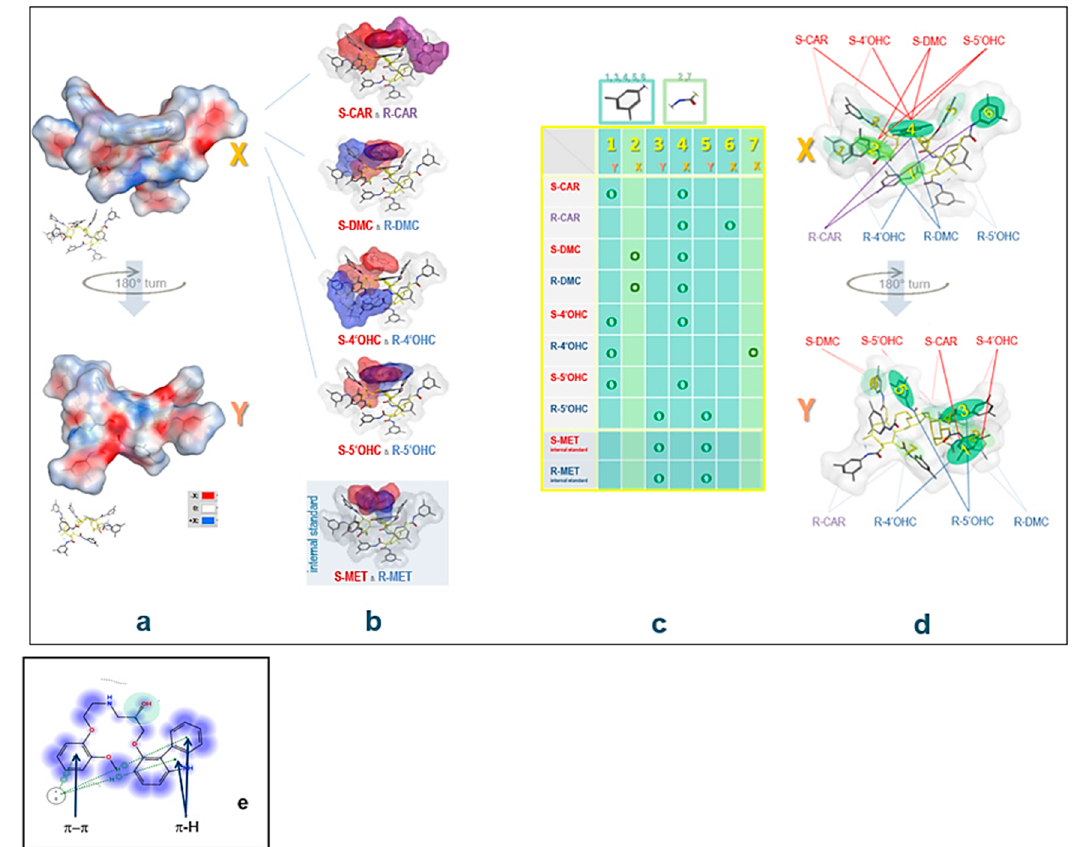
Figure 9. Interactions of CAR, 4 ′ OHC, 5 ′ OHC, and DMC (and MET) enantiomers with the CSP: Highscore docking poses and character of major binding interactions of the analytes at the CSP. Top left side (a,b): ( a ) CSP polar surface (TPSA) of the CSP 3-unit segment, front view = X, back view = Y; ( b ) analyte enantiomers of CAR, DMC, 4 ′ OHC, and 5 ′ OHC attached to grey CSP surface (enantiomer color code: red surface for S -enantiomers (all β -adrenoceptor antagonistic enantiomers, except for the α -/ β -adrenoceptor antagonistic S -CAR), purple surface for the α 1 -adrenoceptor antagonistic R -enantiomer of the parent CAR, blue surface for α 1 -inactive metabolite R -enantiomers). Top right side ( c , d ): ( c ) Binding areas at the CSP: Table listing the two rim regions of high-score binding for each of the analytes, which characterize the expansion of analyte-CSP high-score docking (for all 8 analytes as well as the internal standard). There are seven major regions (1–7), where regions 1, 3, 4, 5, and 6 are representing 3,5-dimethyl phenyl residues and regions 2 and 7 the carbamate spacers. The respective location on the CSP surface is indicated, X = front, Y = back. ( d ) Location of regions 1–7 on the CSP unit: X front view, Y back view, regions 2, 4, 6, and 7 are located on the front side, regions 1, 3, and 5 on the back side. Bottom ( e ): Binding forces involved in the docking of, e.g., S -CAR: Binding includes H-arene and π - π stacking (for the two terminal aromatic systems) and hydrophobic interactions (for the bridging middle chain). The OH at the chiral center (marked in light green) interacts with the carbonyl in the CSP (H-bonding). For all analytes, major CSP-binding forces include π - π and H- π for the 3,5-dimethyl phenyl and dipole-dipole for the carbamate